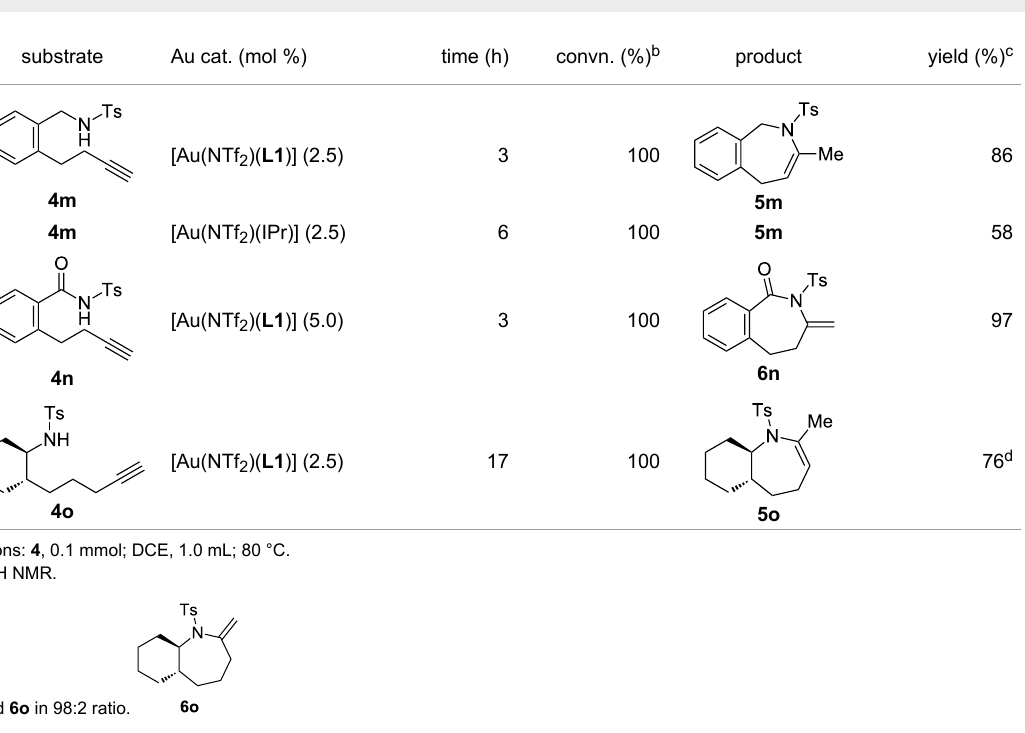
Table 4: Cyclization of alkynic sulfonamide with a ring-fused linker. a